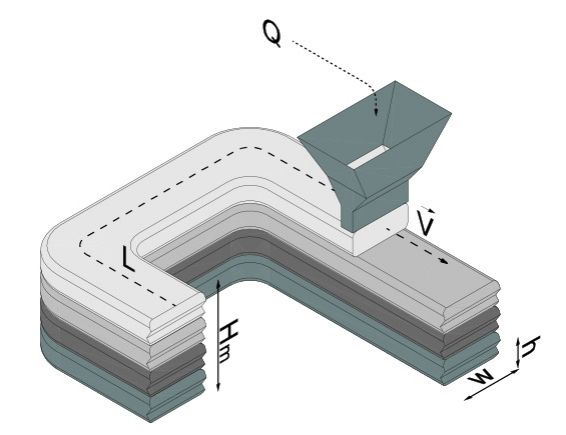
Figure 5. Schematic of a layered extrusion process with concrete. A digitally controlled extrusion head moves at velocity V, creating layers of individual height h and width w. The overall height, Hm, is dependent on the velocity and contour length,